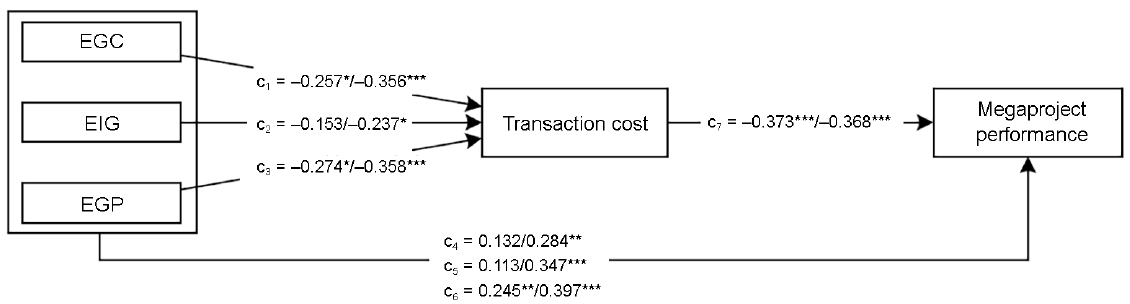
Figure 2. Results of structural equation